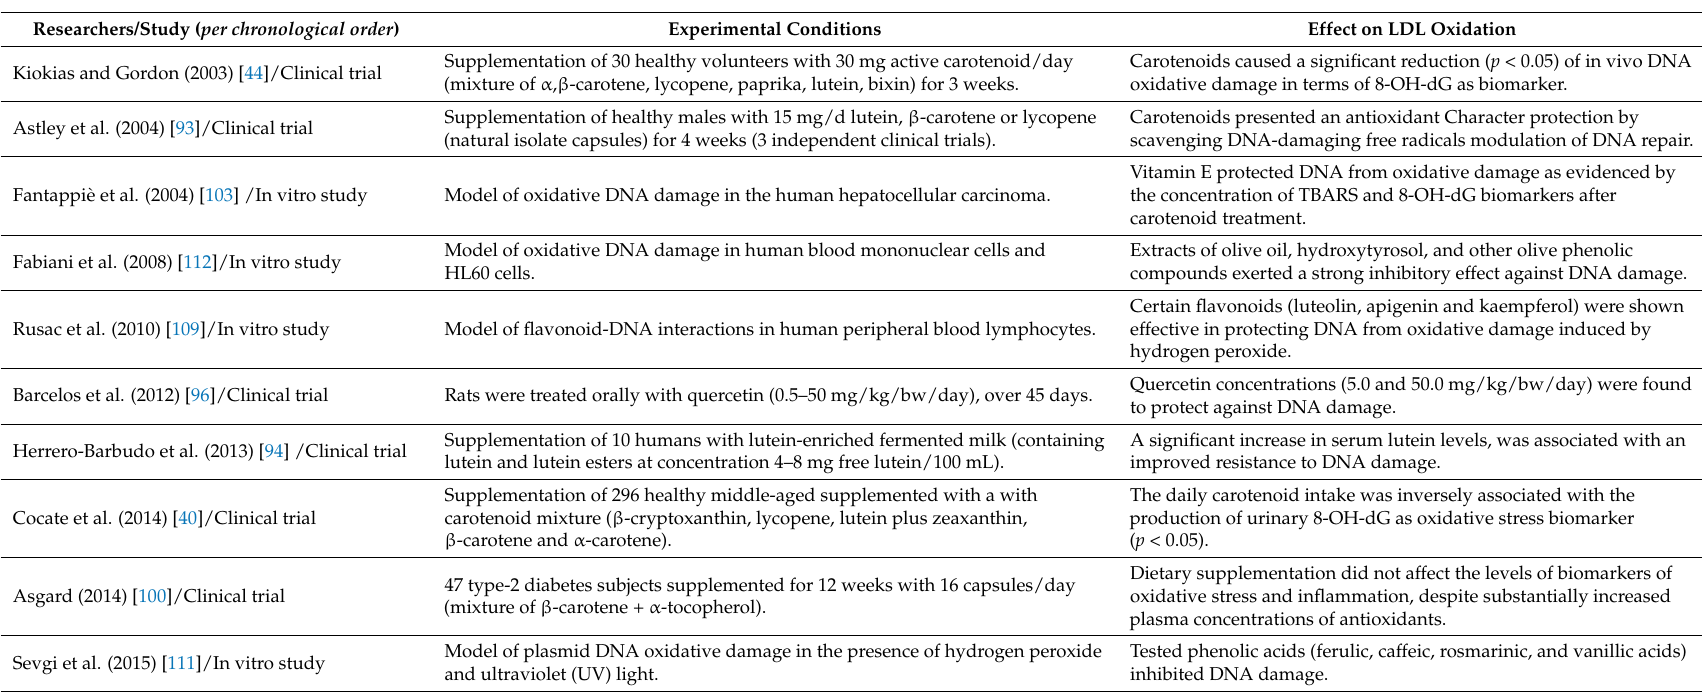
Table 2. Selection of studies on the effect of natural antioxidants against DNA oxidative damage (conducted during the last 15